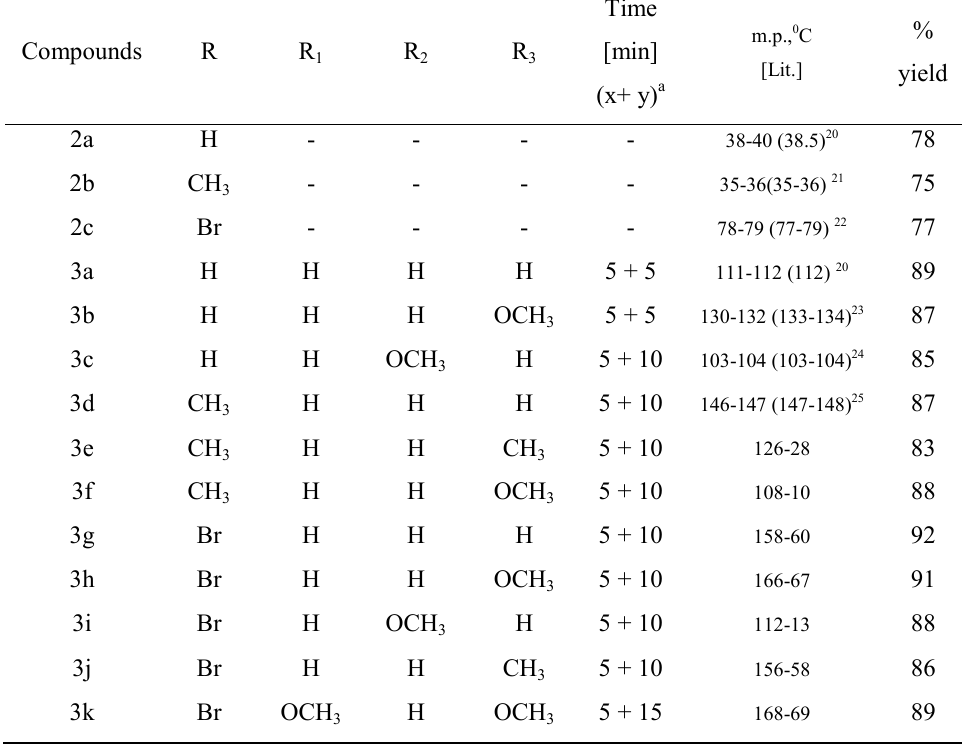
Table 1. Physical data of the compounds synthesized.